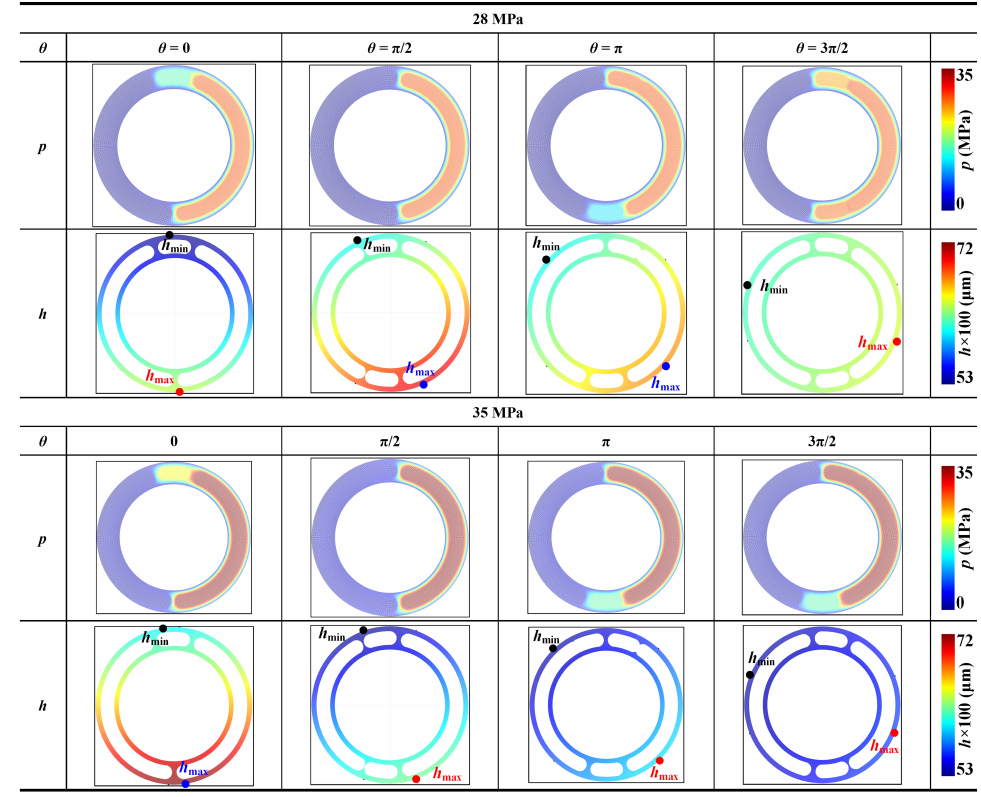
Figure 15. Oil film pressure and thickness